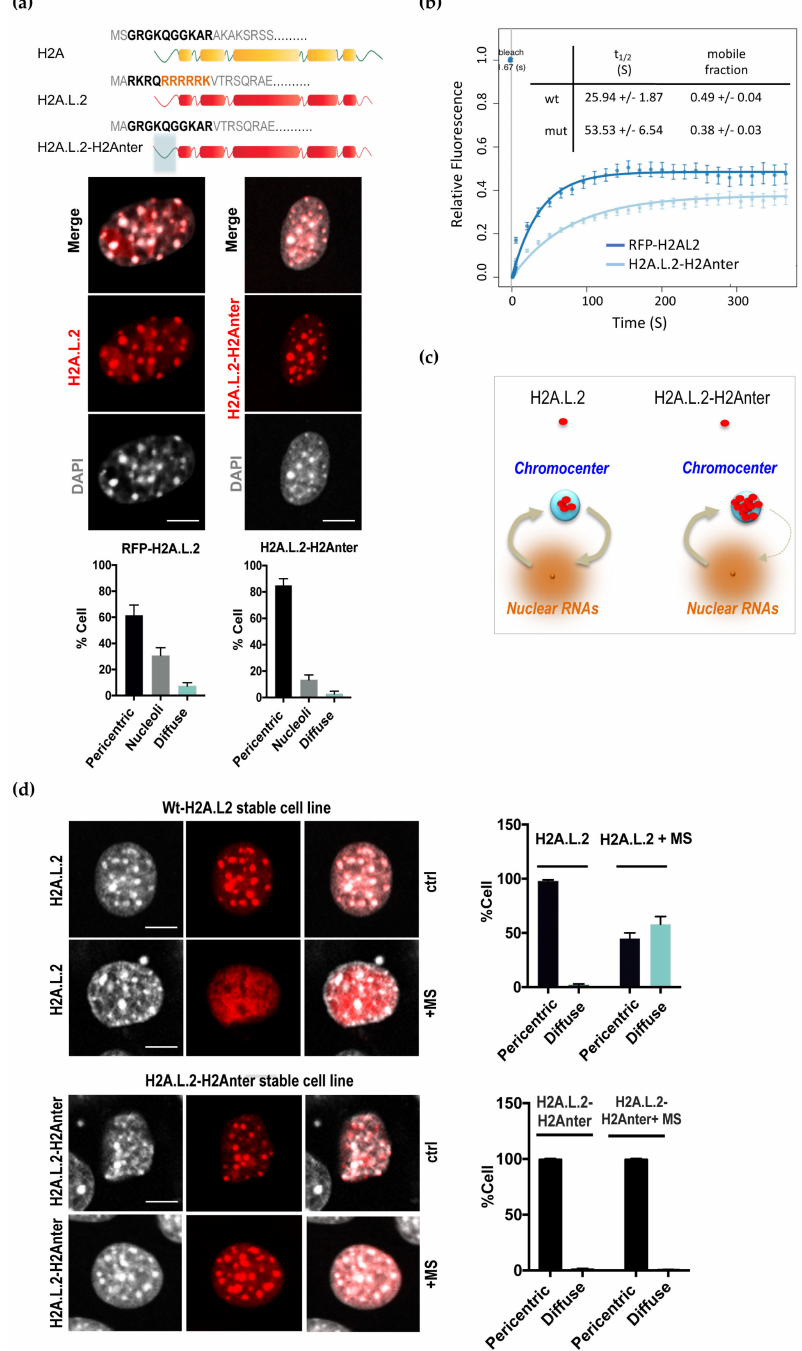
Figure 2. RNA-controlled dynamic pericentric localization of H2A.L.2. ( a ) NIH3T3 cell transiently expressing RFP-H2A.L.2 or a mutated version of RFP-H2A.L.2 with the replacement of its N-terminal sequence with that of H2A, named H2A.L.2-H2Anter, were obtained and the intracellular